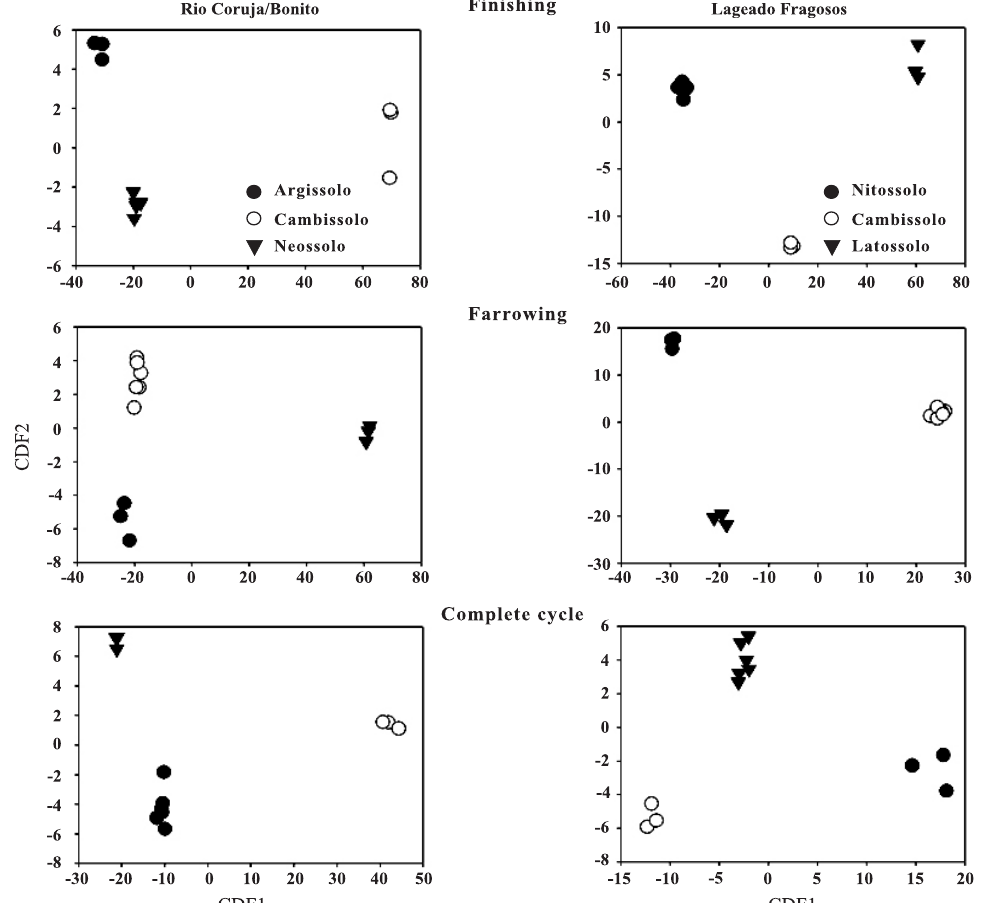
Figure 1. Standardized canonical coefficients of the canonical discriminant functions (CDF) 1 and 2 in three soil types, according to the location and pig production system, considering the total and available heavy metals Cu, Zn and